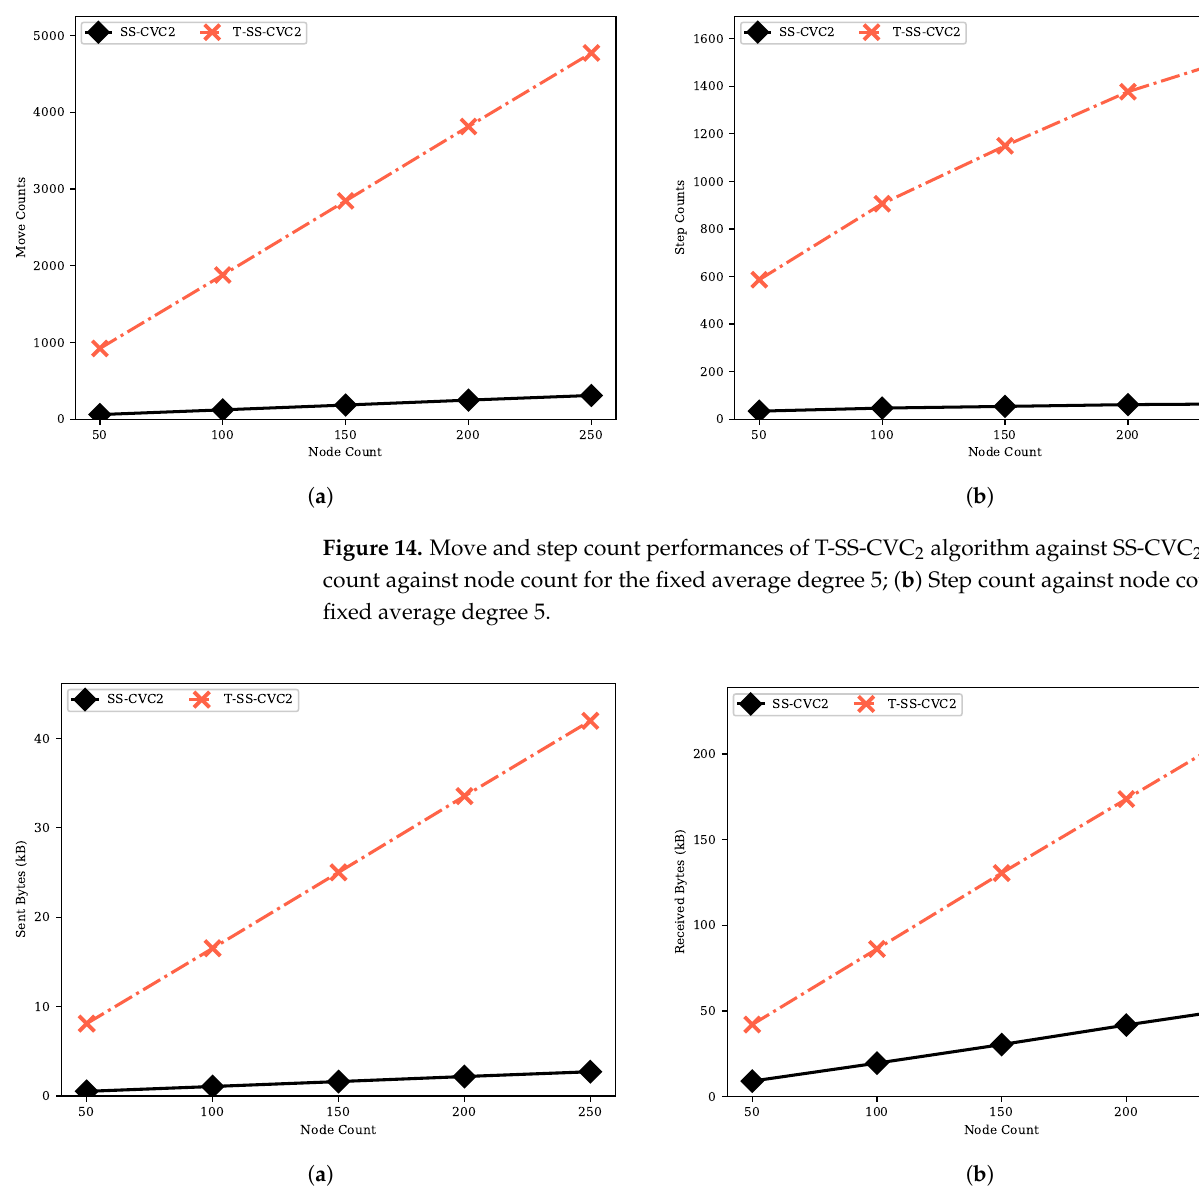
Figure 15. Sent and received bytes performances of the T-SS-CVC 2 algorithm against SS-CVC 2 : ( a ) Sent bytes against node count for the fixed average degree 5; ( b ) Received bytes against node count for the fixed average degree